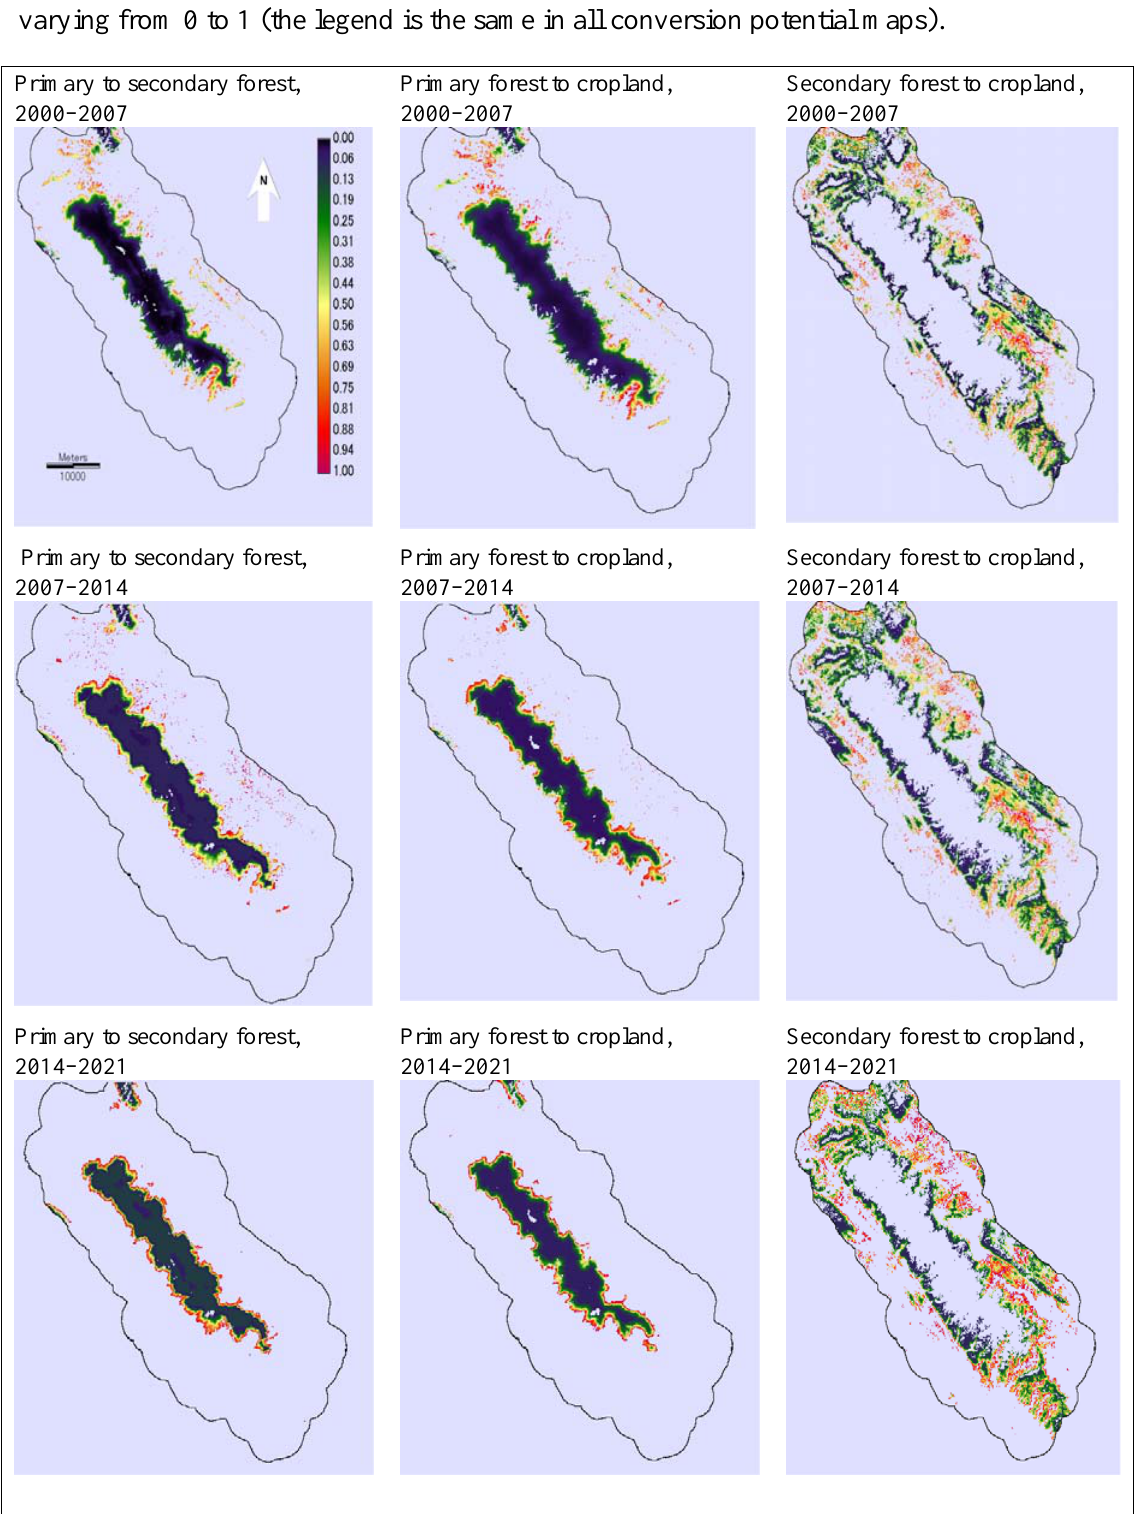
Figure 8. Forest conversion potential maps consisting of pixels with continuous scores varying from 0 to 1 (the legend is the same in all conversion potential